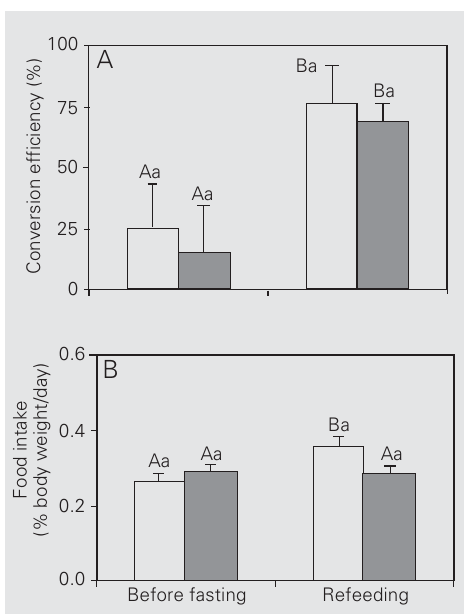
Figure 3. Effect of fasting and